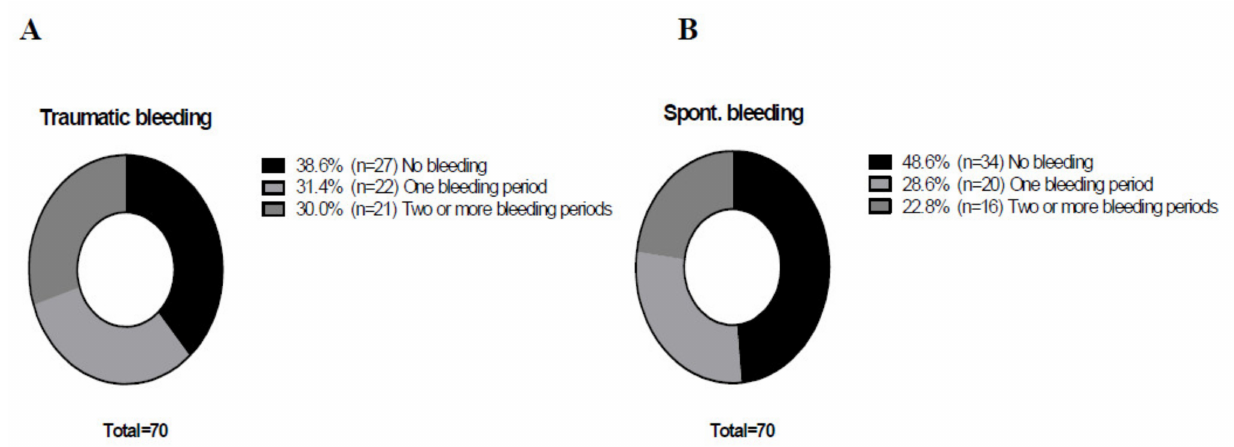
Figure 1. Proportion of patients experiencing either traumatic ( A ) or spontaneous ( B ) bleeding episodes throughout the study’s designated bleeding